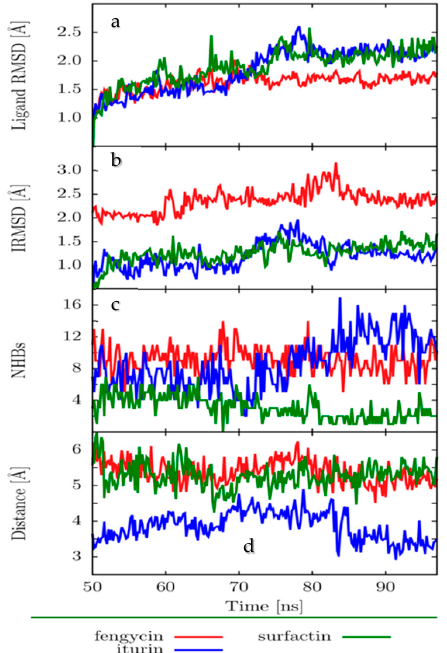
Figure 5. Time evolution of ( a ) the ligand root means square deviation (RMSD), ( b ) the interface RMSD (IRMSD), ( c ) the number of H-bonds between the protein and ligand, and ( d ) the distance between the ligand and tubulin-binding site. Analysis was performed by Gromacs.